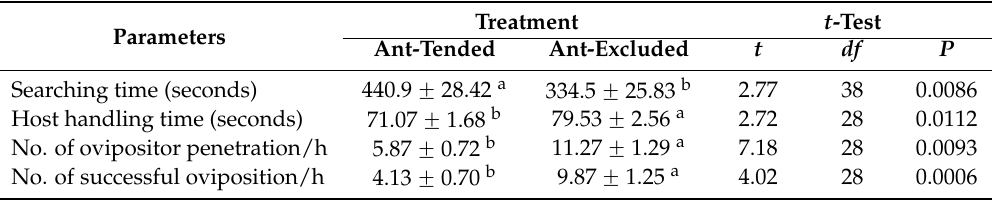
Table 2. Mean ( ˘ SEM) host searching time, host handling time, ovipositor penetration and successful oviposition per h, when Anagyrus pseudococci females foraged in the presence or absence of Oecophylla